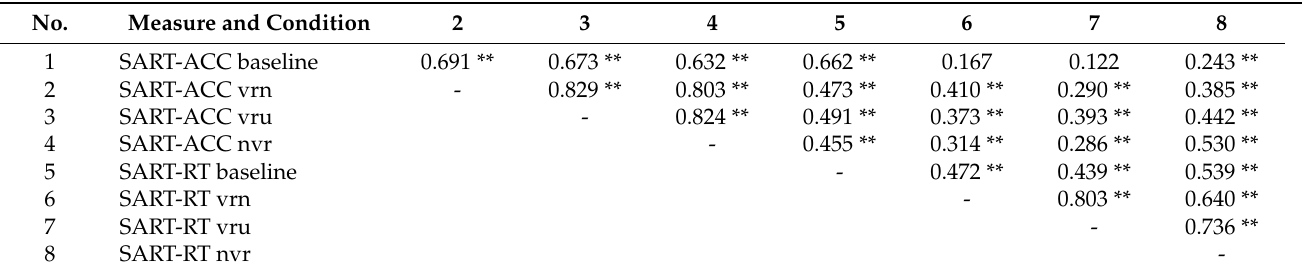
Table 3. Correlation values for speed (RT) and accuracy (ACC) measures of the SART across three